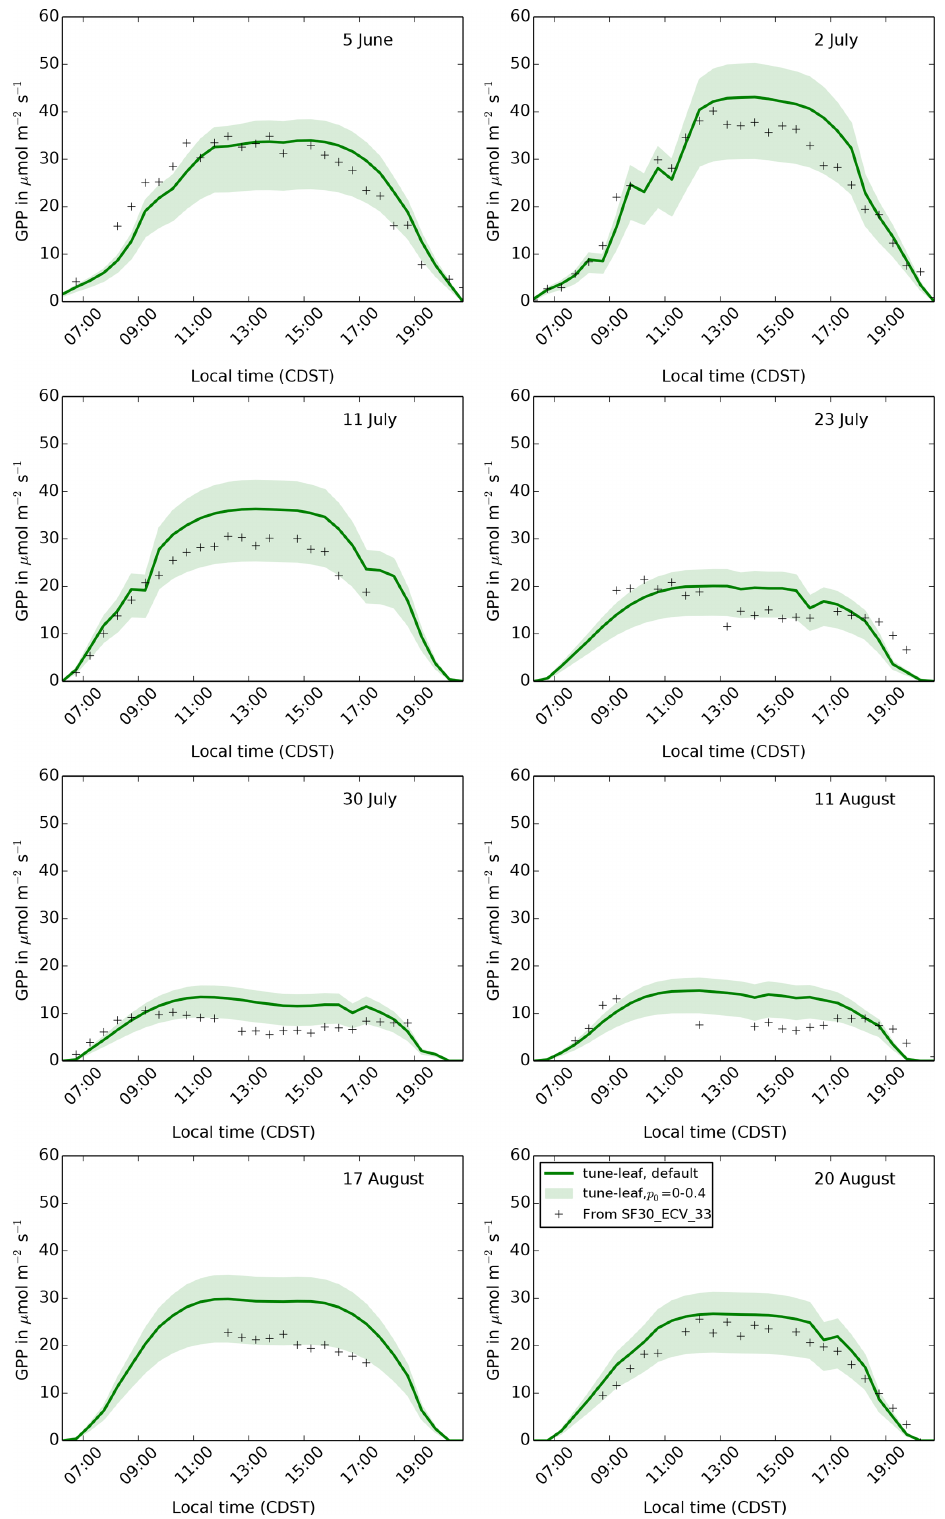
Figure 12. The diurnal cycle of GPP at site 4439 in the FIFE area for 8 days in 1987: 5 June (early growth), 2 and 11 July (peak growth), 23 July, 30 July and 11 August (dry period), and 17 and 20 August (early senescence). Green band shows how the tune-leaf simulation would vary for p 0 in the range 0 to 0.4 (lower limit corresponds to p 0 = 0, upper limit to p 0 = 0 .